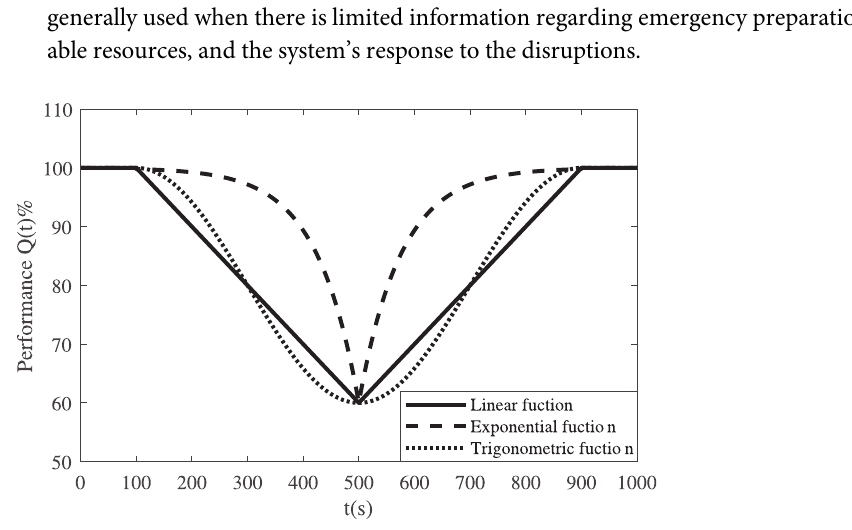
Fig 2. Typical system performance process